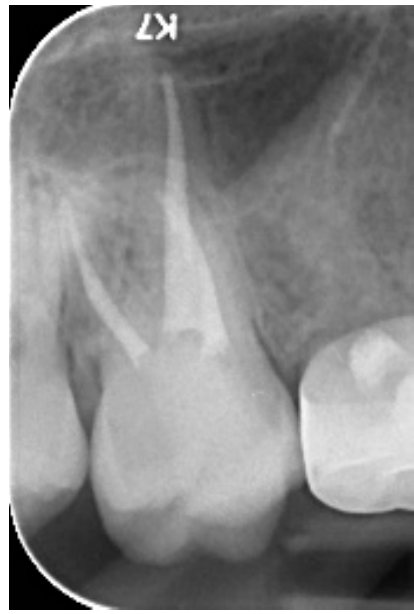
Figure 2. An X-ray after the completion of root canal treatment in the upper right first molar.